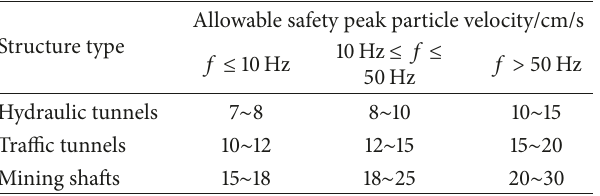
Table 2: Safety vibration limitation for tunnels and shafts in China